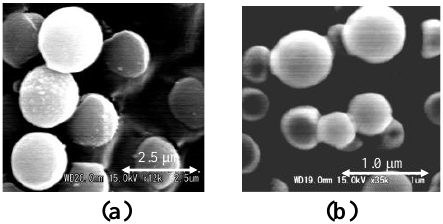
Figure 4. SEM image of measured objects: ( a ) Diameter: 2.0 μm (KMP-590); ( b ) Diameter: 700 nm (X-52-854).